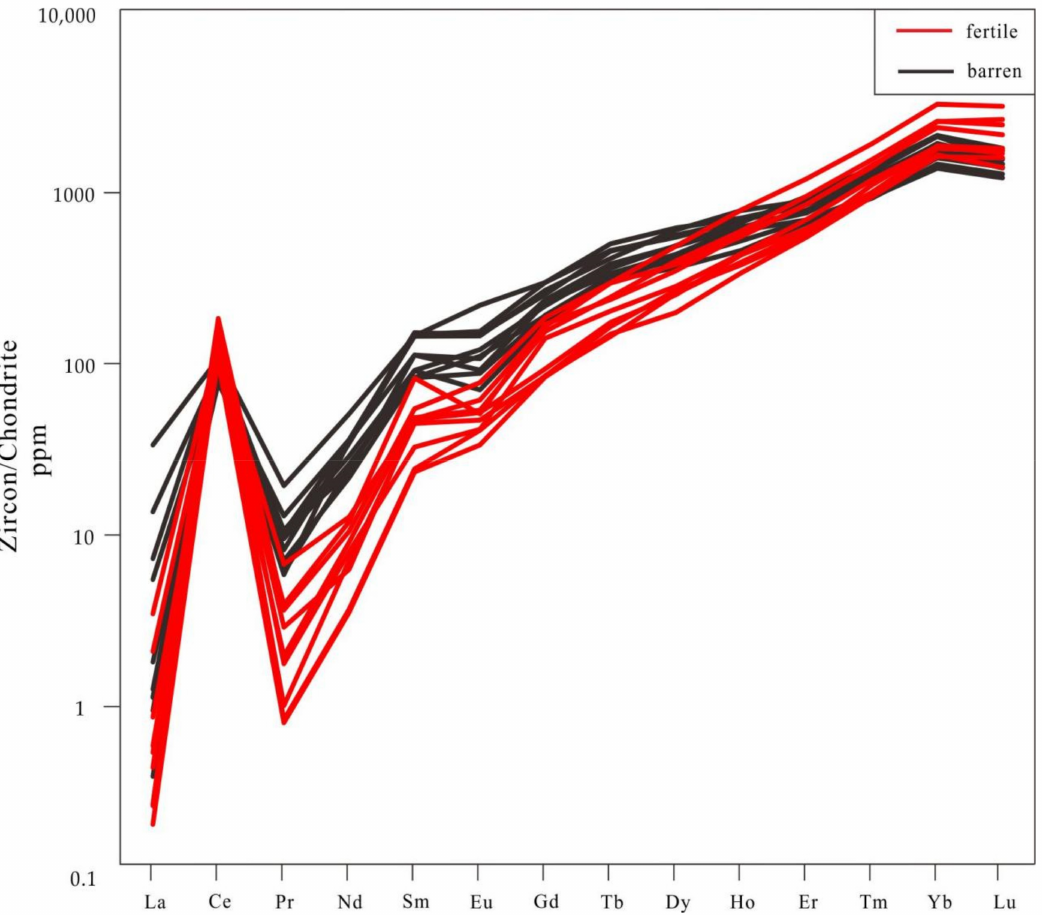
Figure 6. Zircon REE patterns of samples from the Yao’an gold deposit [67]. The chondrite-normalized patterns are depleted in LREE and enriched in HREE and are characterized by positive Ce anomalies with variable negative Eu